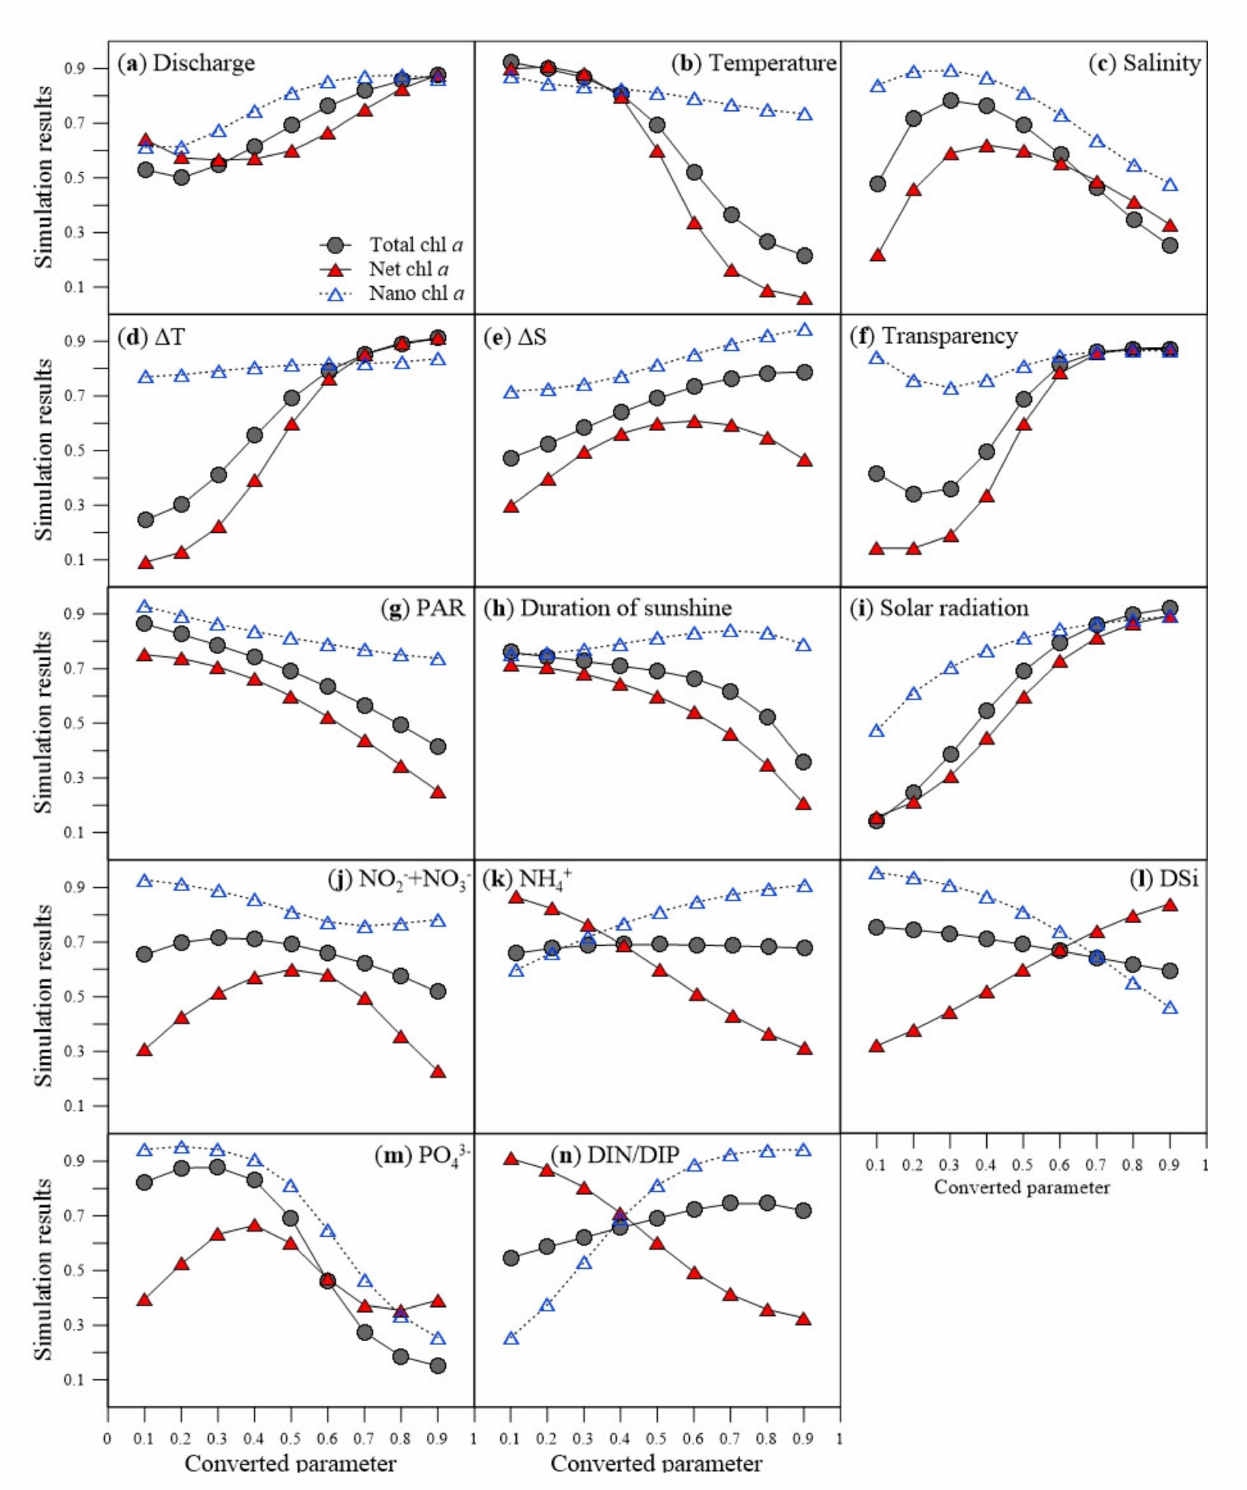
Figure 5. Relationship between input parameters (environmental factors) and predicted chlorophyll a values in the ANN modeling analyses. ( a ) fresh water discharge (dicahrge), ( b ) water temperature (temperature), ( c ) salinity, ( d ) surface and bottom temperature difference ( ∆ T), ( e ) surface and bottom salinity difference ( ∆ S), ( f ) transparency, ( g ) photosynthetically active radiation (PAR), ( h ) Duration of sunshine, ( i ) solar radiation, ( j ) nitrite + nitrate (NO 2 − + NO 3 − ), ( k ) ammonium (NH 4 + ), ( l ) dissolved silicate (DSi), ( m ) phosphate (PO 4 3 − ), and ( n ) dissolved inorganic nitrogen to dissolved inorganic phosphorus ratio